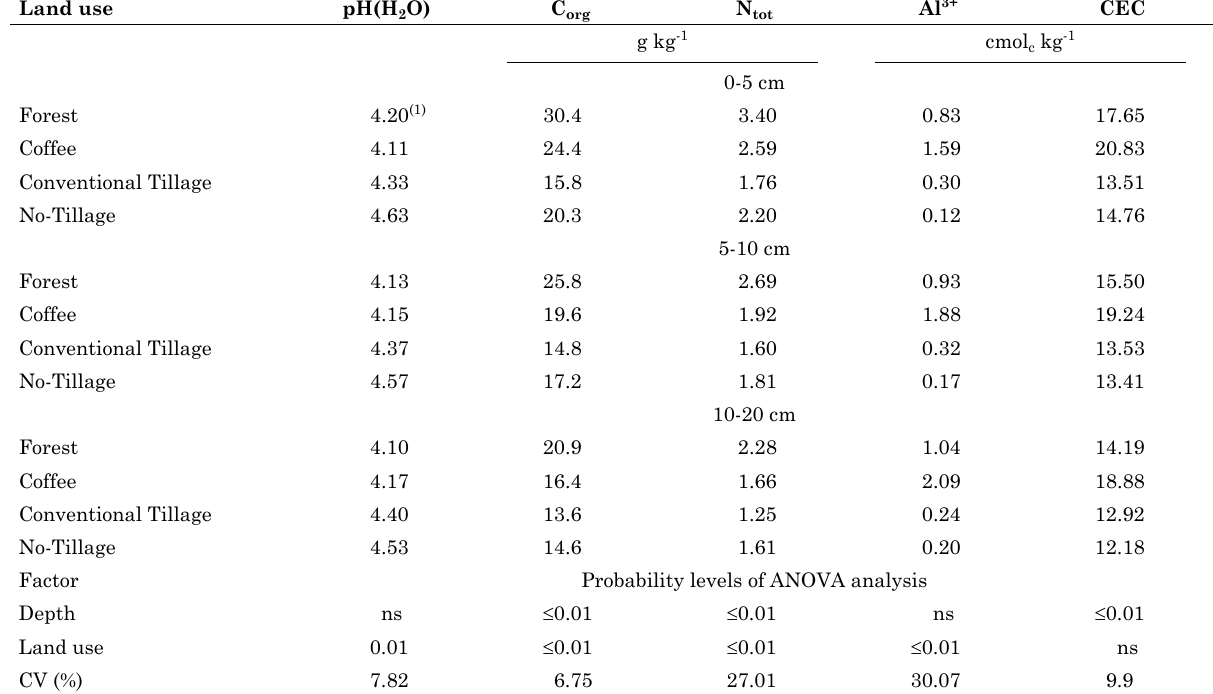
Table 2. Chemical properties of a southern Brazilian Oxisol 24 years after forest conversion to a perennial crop with coffee or annual grain crops (maize and soybeans) in conventional tillage or no-tillage land